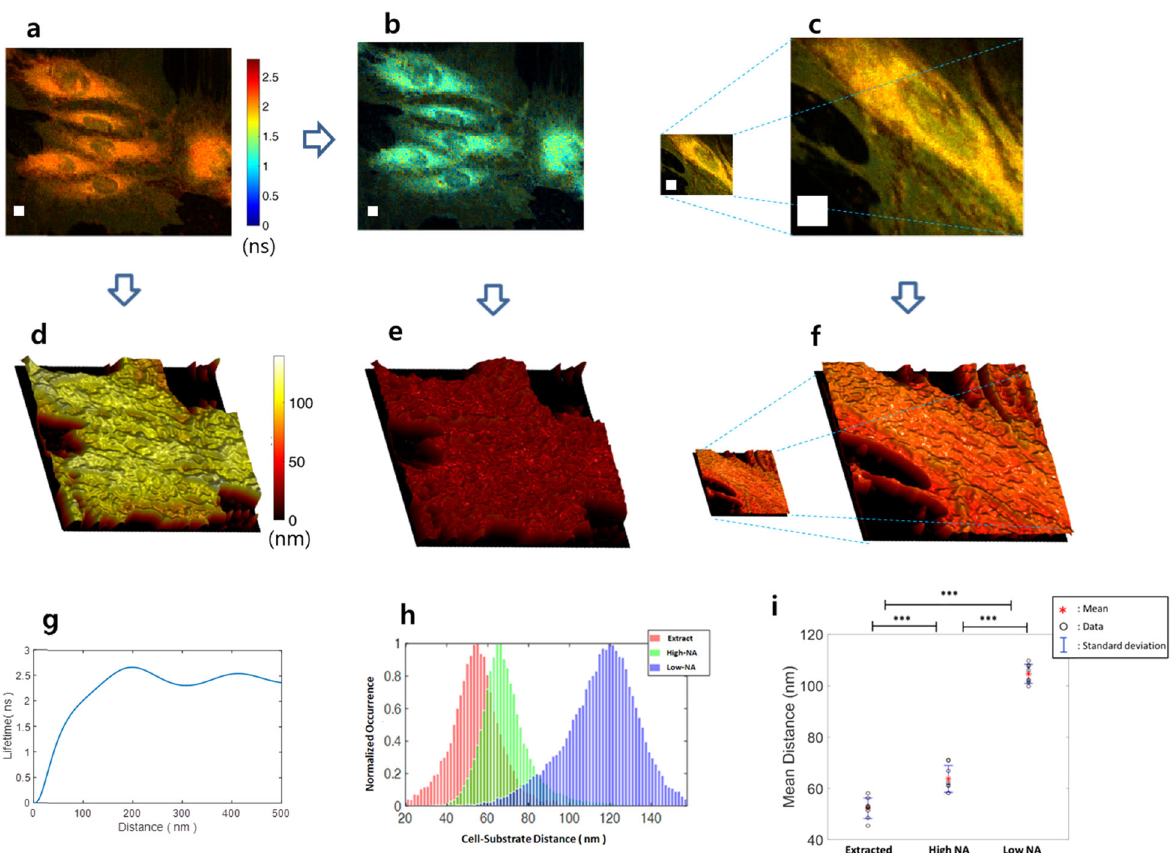
Fig. 2 3D surface plots of cell – substrate distance measured with high-NA and low-NA objectives. a Large-FOV (120 μ m × 96 μ m) FLIM image of HAECs measured with the low-NA objective. b Reconstructed FLIM image with shorter lifetimes calculated by using biexponential signal analysis. c Small-FOV (40 μ m × 32 μ m) FLIM image measured with the high-NA objective for the HAECs sample. White boxes in ( a – c ) are squares of 5 μ m side length. d – f 3D surface plots of cell – substrate distance converted from three FLIM images shown in ( a – c ). g Lifetime-to-distance conversion curve by the CPS model ( “ Methods ” ). h Normalized distributions of cell – substrate distances for the three images shown in ( d – f ). i Average cell – substrate distances and their standard deviations for the three surface pro fi les shown in ( d – f ). Eight different cell images were measured for statistical